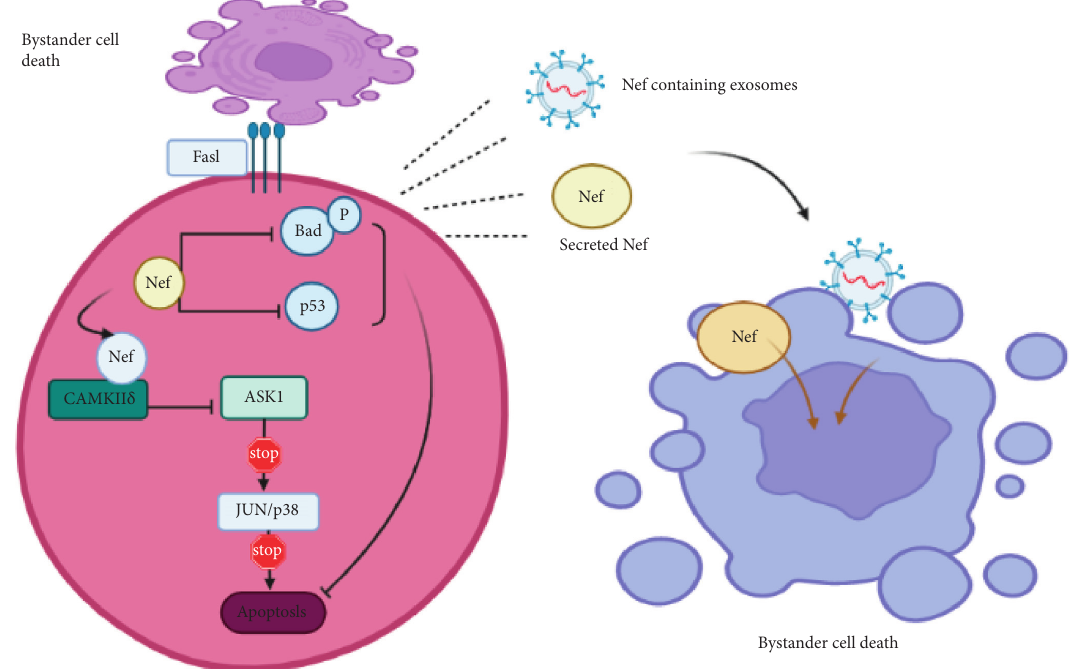
Figure 2: Role of Nef proteins in inducing bystander cell death.